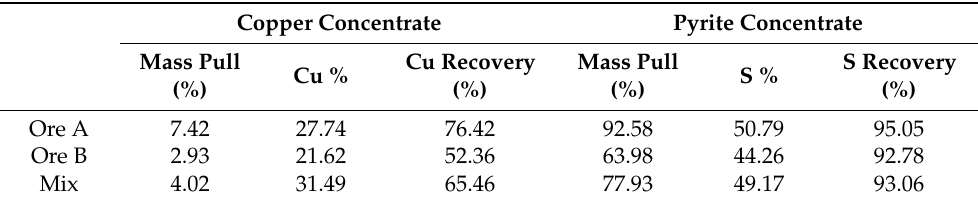
Table 8. Flotation performance of Ore A, Ore B and a mixture of the two ores under optimum flotation conditions applied on each ore